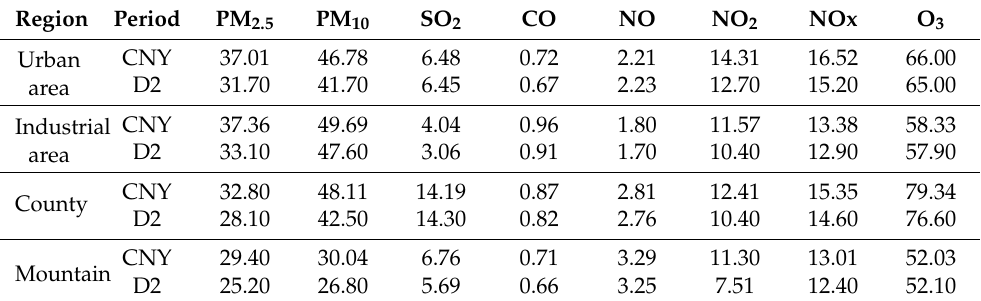
Table 3. Mean concentration of PM 2.5 ( µ g/m 3 ), PM 10 ( µ g/m 3 ), SO 2 ( µ g/m 3 ), CO (mg/m 3